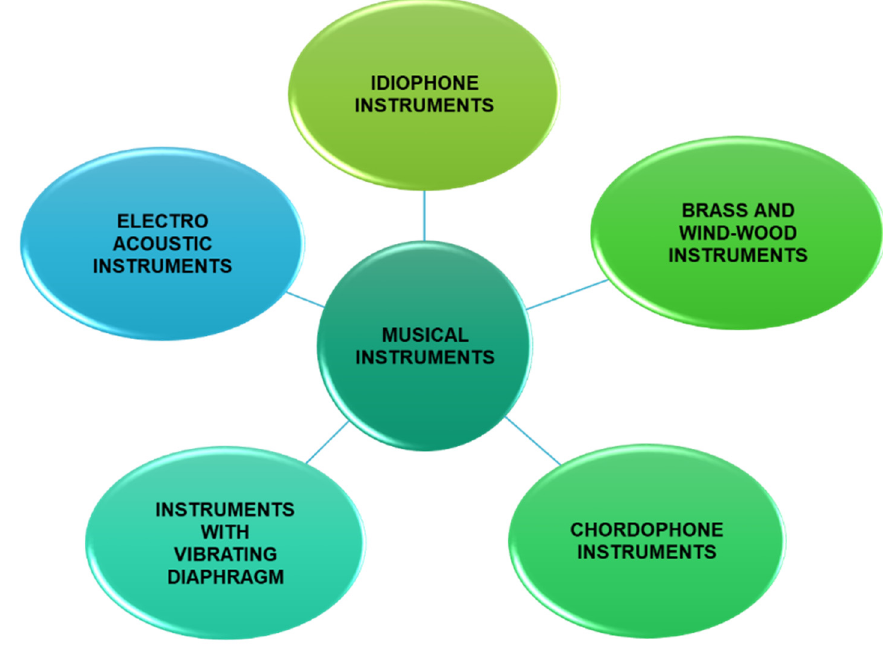
Figure 1. Types of musical instruments.